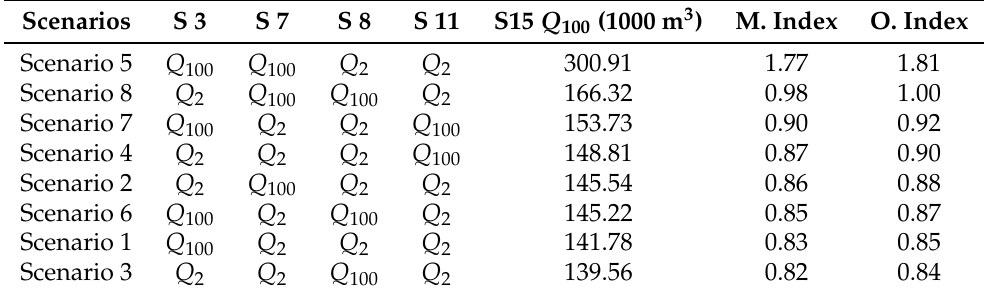
Table 5. Classification of possible scenarios according to the severity of the extreme quantile of station 15. M. index: Marginal index. O. index : Observed index.